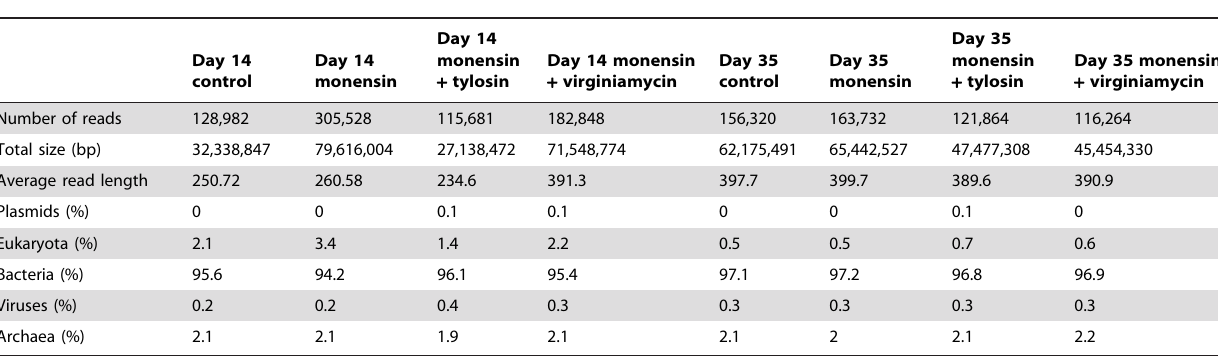
Figure 8. Hierarchical clustering of OTU similarity and group similarity using normalized abundances. Key genera are highlighted to the right of each cluster. For each timepoint (D0, D7, D14, and D35), C = control diet, M = monensin treatment, V = monensin/virginiamycin treatment, and T = monensin/tylosin treatment. doi:10.1371/journal.pone.0027949.g008 Table 2. Summary of shotgun metagenome sequencing of chicken cecum